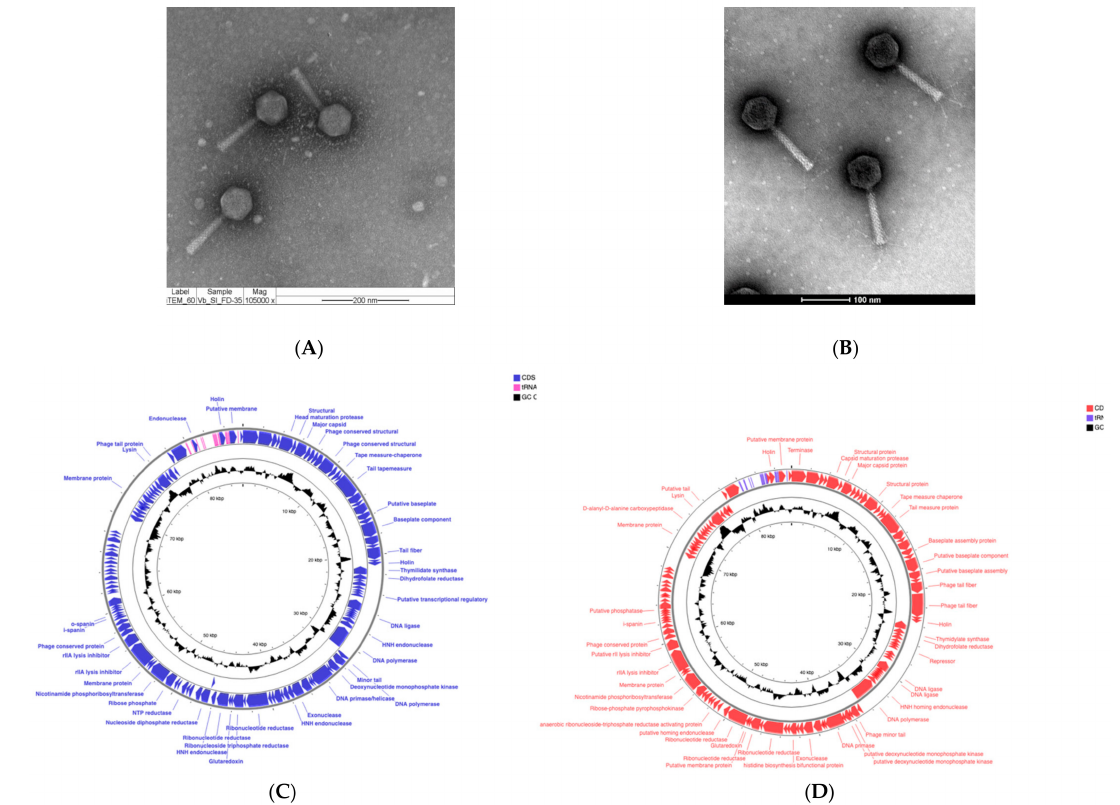
Figure 1. Morphological and genomic characterization of sequenced phages. ( A ) Image obtained by TEM, vB_Si_35FD, ( B ) vB_Si_DR094, both phages exhibit icosahedral capsids and long straight tails, which is consistent with the morphology of the Myoviridae family. ( C ) Visualization of the complete genome of vB_Si_35FD sized 85 kb with 129 identified CDS (blue); most of the genes were transcribed from the forward strand (external CDS) and 19 tRNAs (pink); in black is the G+C content that, on average, was 38.9%. ( D ) vB_Si_DR094 genome visualization, sized 85.7 kb with 125 identified CDS (red); in purple are marked 20 tRNAs, and the G+C% on average was 39.2%